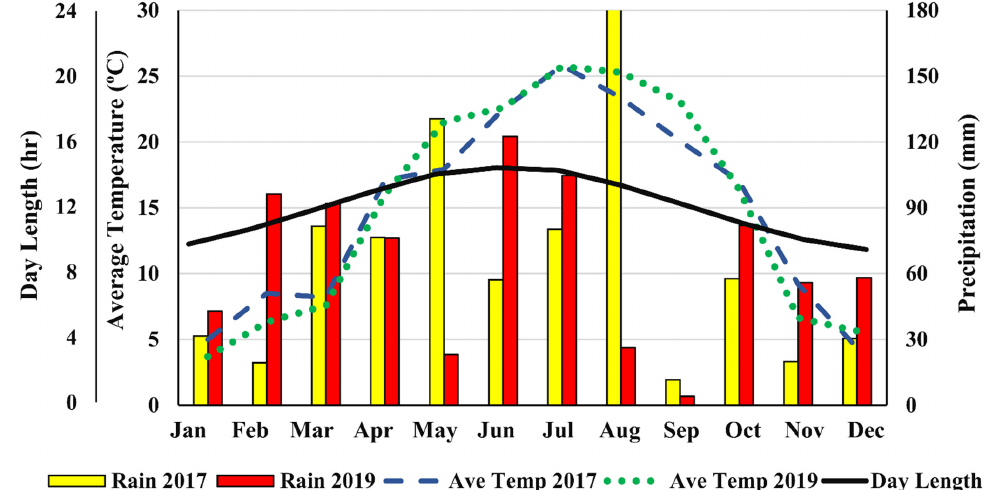
Figure 1. Weather history (average temperature, total precipitation, and day length), Petersburg, Virginia, 2017 and 2019 [41].